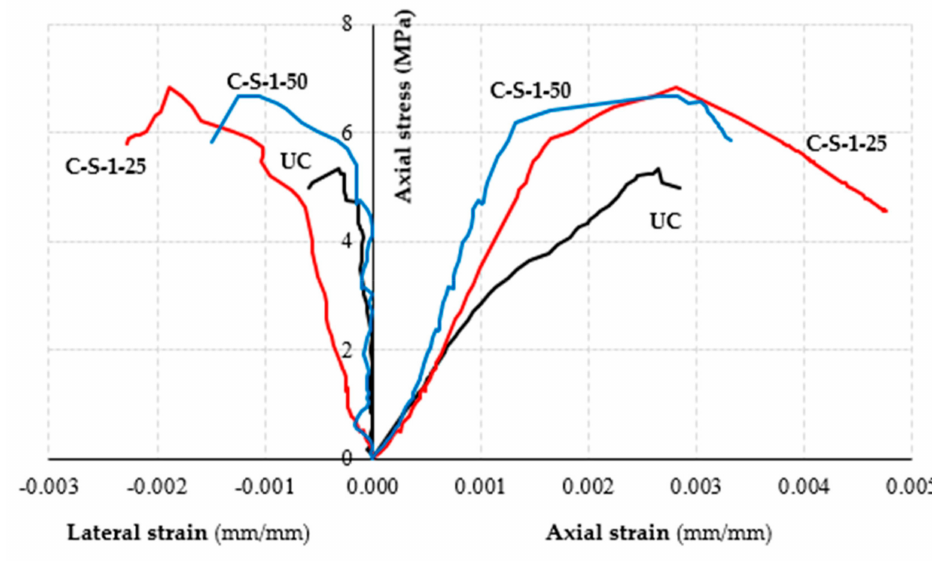
Figure 17. Axial stress-strain curves for eccentrically loaded SRG confined